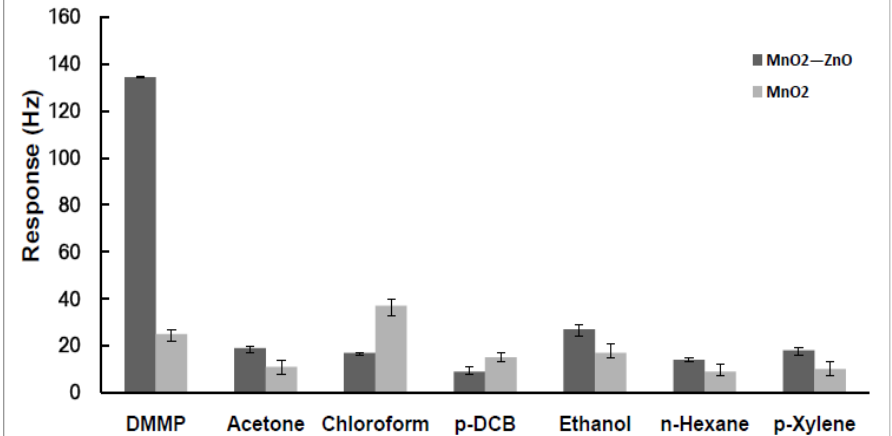
Figure 7. Comparison of the responses between the sensor based on pure MnO film and ZnO-modified MnO predefined concentration of 0.7